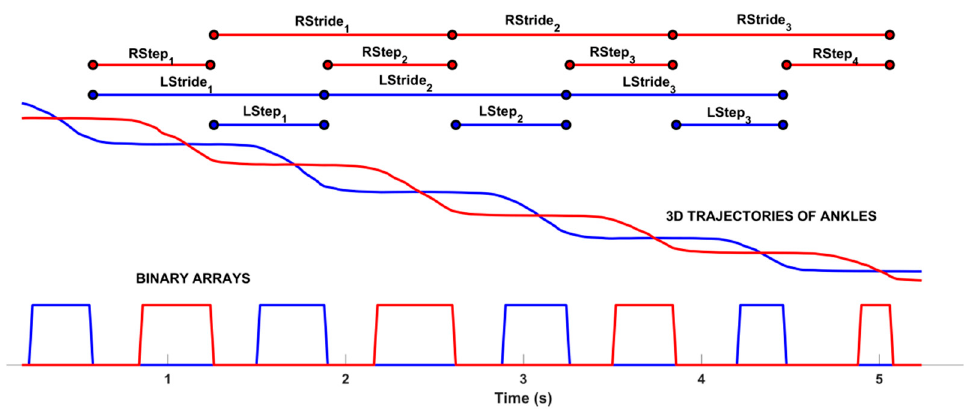
Figure 2. Results of the step segmentation algorithm: binary arrays for left (square line in blue) and right (square line in red) ankles estimated from 3D trajectories. At the top, some of the spatio-temporal parameters are shown; in particular, the step and gait cycle duration.